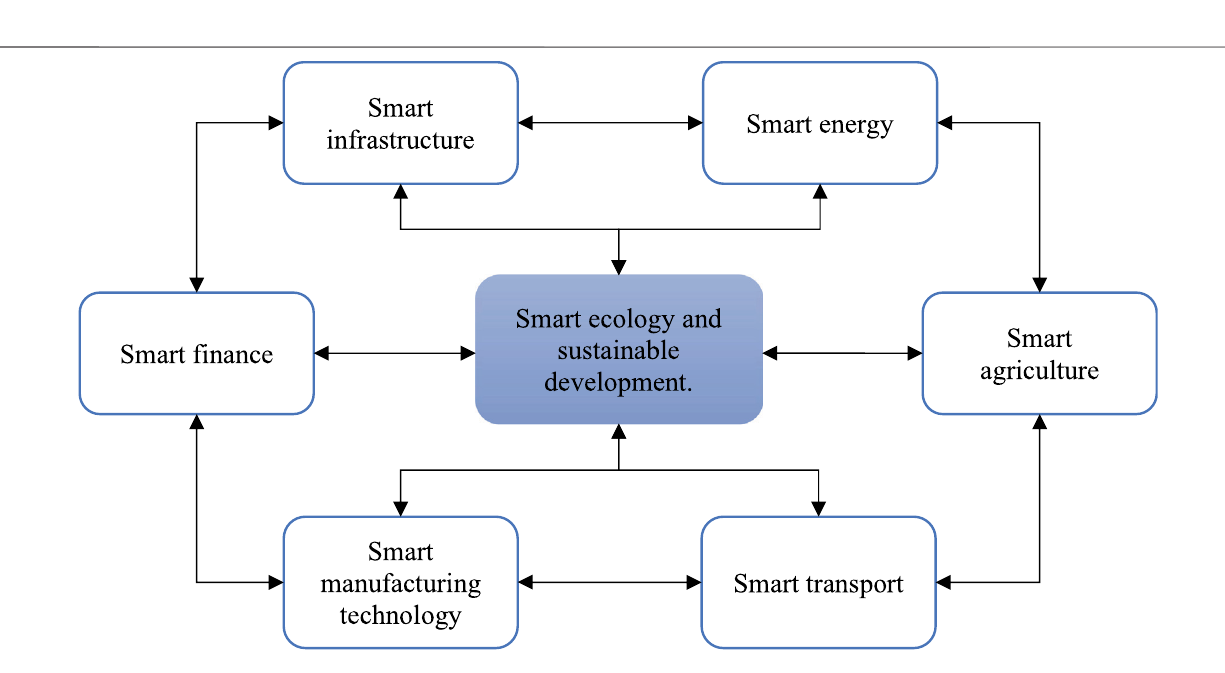
Frontiers in Environmental Science |